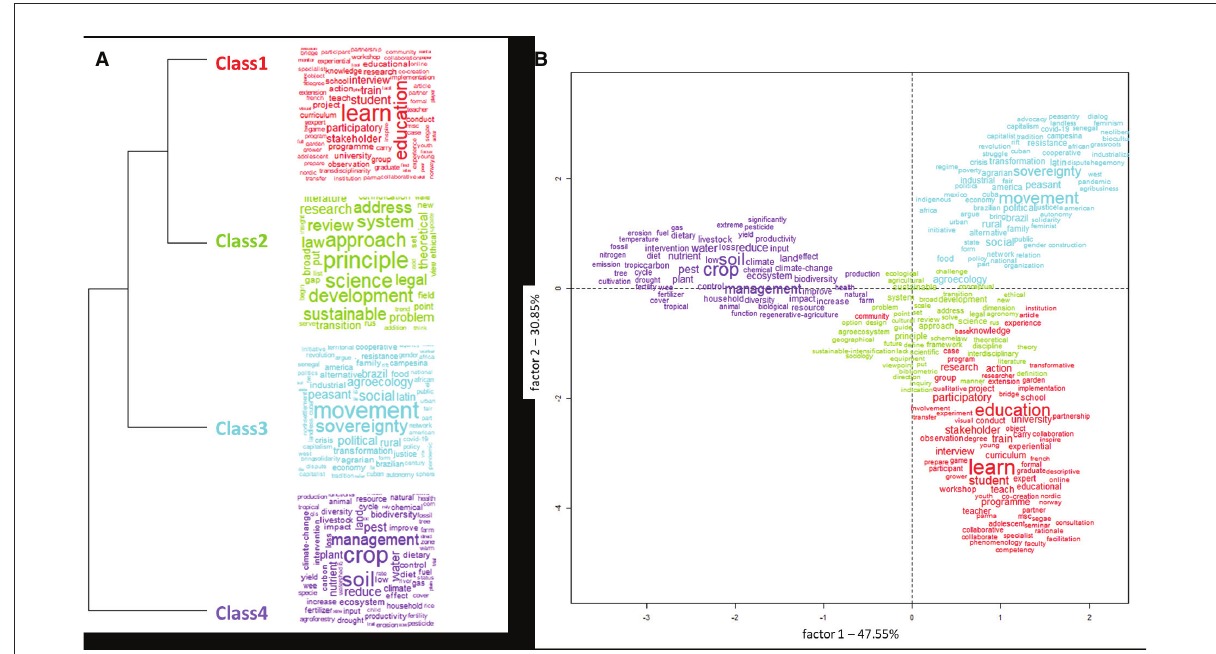
FIGURE2 Reinert’s top-down hierarchical classification ( N = 645). (A) Dendrogram and word-cloud of each class, size of text is proportional to term’s frequency; (B) Post-hoc correspondence factor analysis of term class, size of text is proportional to its Chi2 value and indicates the association strength with the